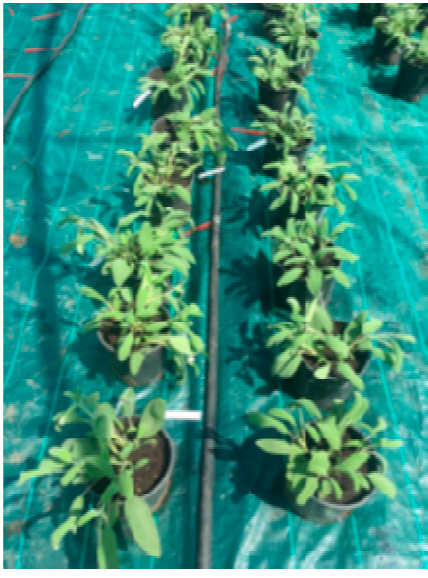
Figure 4. Sage plants repotted into pots having diameter of 18 cm.